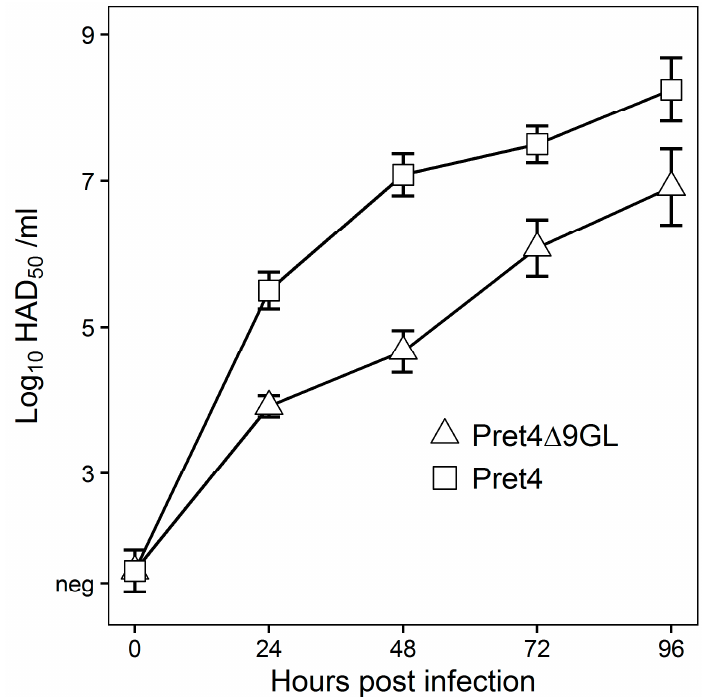
Figure 1. In vitro growth characteristics of Pret4 ∆ 9GL (triangles) and parental Pret4 (squares) viruses. Primary swine macrophage cell cultures were infected (multiplicity of infection (MOI) 0.01) with either Pret4 ∆ 9GL or Pret4 and virus yield titrated at different times post infection. Data represent mean and standard deviation (SD) from three independent experiments. Limit of detection: 1.5 hemadsorption (HAD) 50 /mL. Neg: negative.